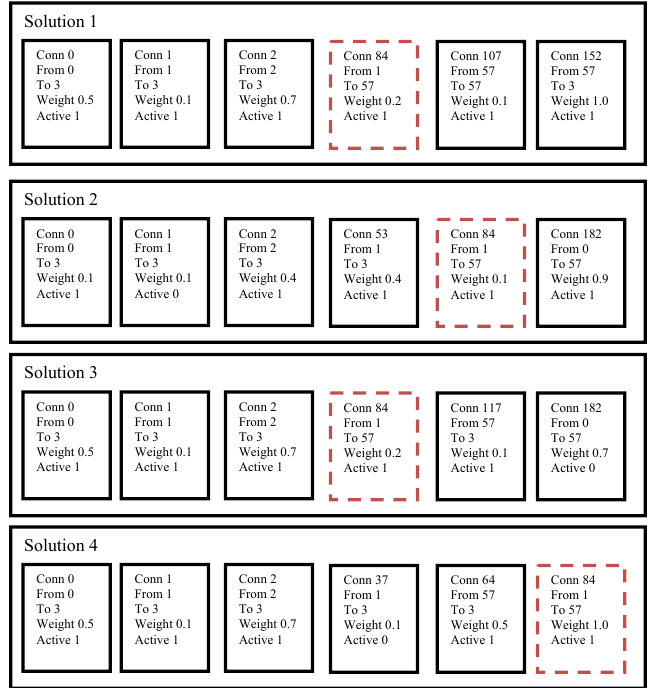
Figure 2. Identifying same genes to perform the difference-based